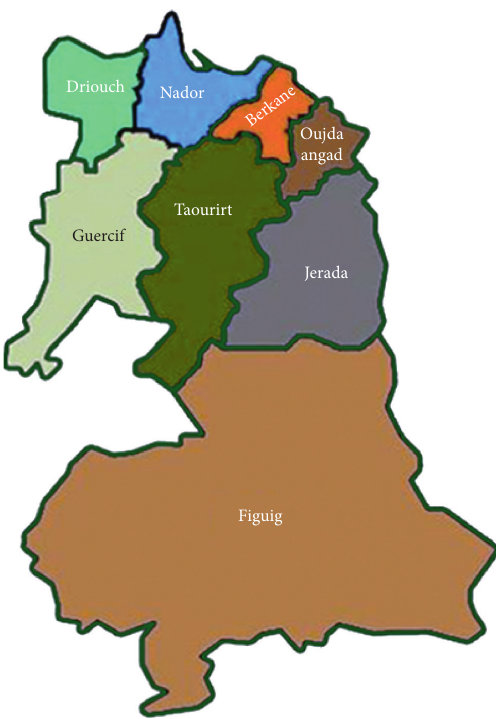
Figure 1: Region of Oriental in Morocco. This region is divided ) , into eight subregions (or domains) ( Ω j ) : Oujda Angad ( Ω 1 ⩽ j ⩽ 8 1 ) , Nador ( Ω ) , Driouch ( Ω ) , Guercif ( Ω ) , Taourirt Berkane ( Ω 2 3 4 5 ( Ω ) , Jerada ( Ω ) , and Figuig ( Ω ) 6 7 8